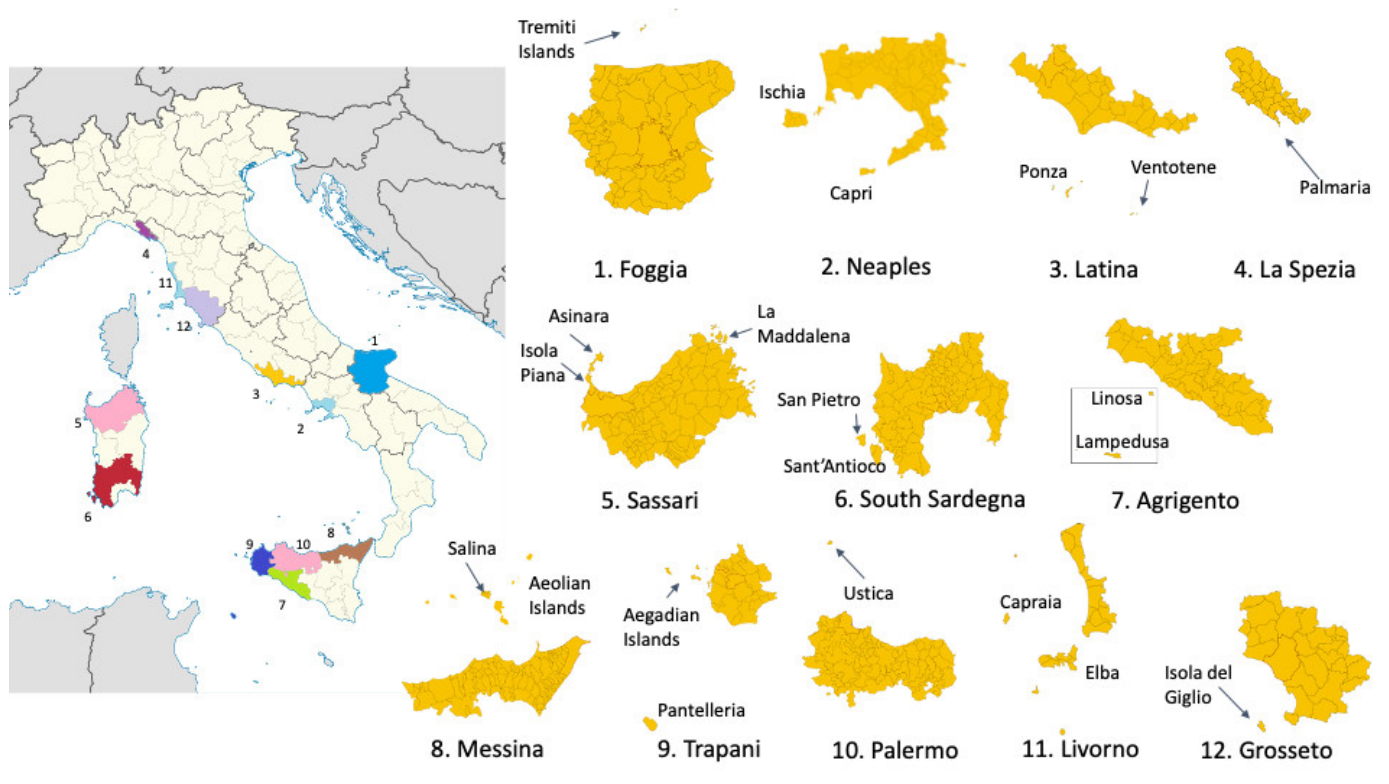
Figure A1. Italian small islands and their respective parent provinces.